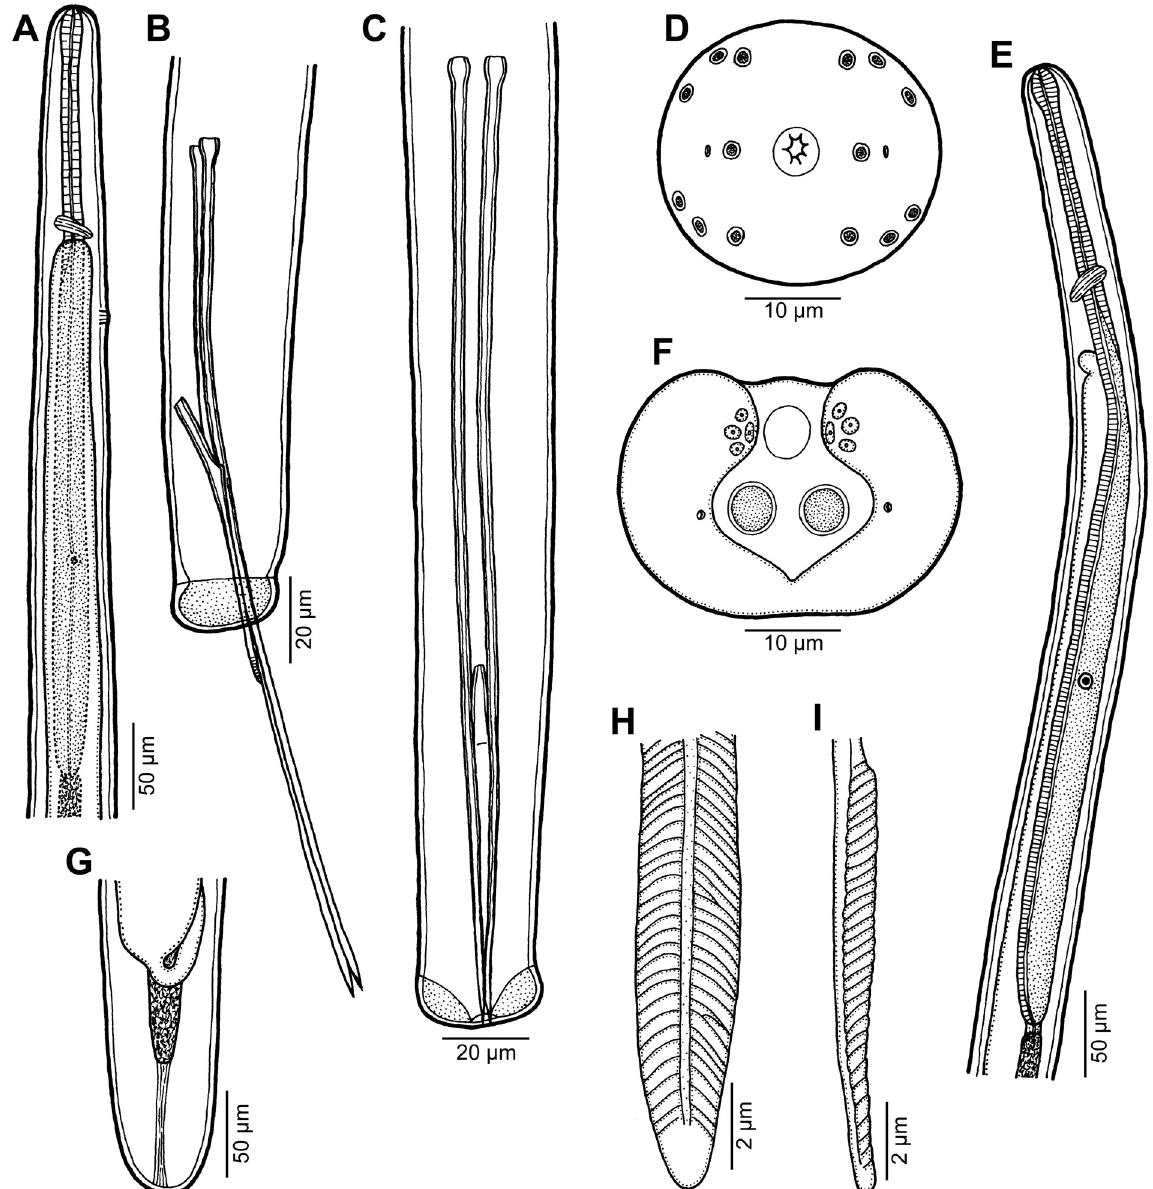
Figure 3. Philometra jordanoi (López-Neyra, 1951). A: Anterior end of male, lateral view. B, C: Posterior end of male, lateral and ventral views, respectively. D: Cephalic end of male, apical view. E: Anterior end of mature female, lateral view. F: Caudal end of male, apical view. G: Posterior end of mature female, lateral view. H, I: Posterior end of gubernaculum, dorsal and lateral views,